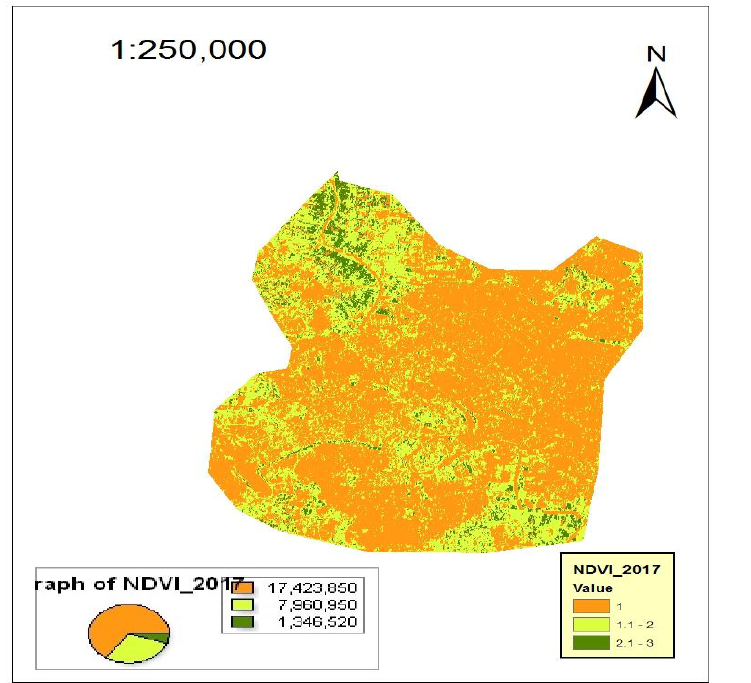
Fig.16: Show image NDVI classification for study area in date